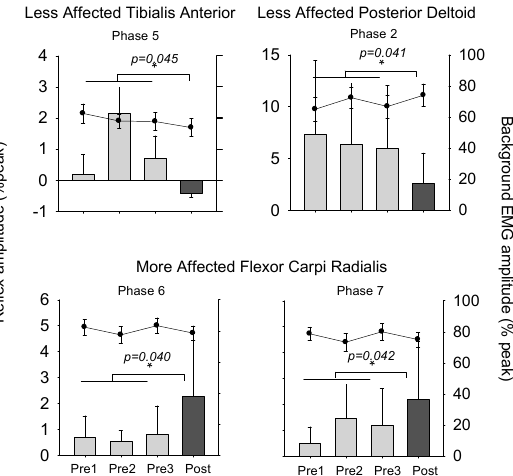
Figure 7. Normalized background EMG and reflex amplitudes at specific phase of interest during A & L cycling. Bar graphs are means (± standard error) for reflex amplitude averaged across all participants for baseline and post-test values. Line graphs are means (± standard error) for bEMG. Repeated-measures ANOVA was used to assess the effects of A & L cycling training with significance set at p ≤ 0.05. p -values are shown for each test. * indicates significant differences between the pretest average and the post-test value. There were no significant differences for bEMG.